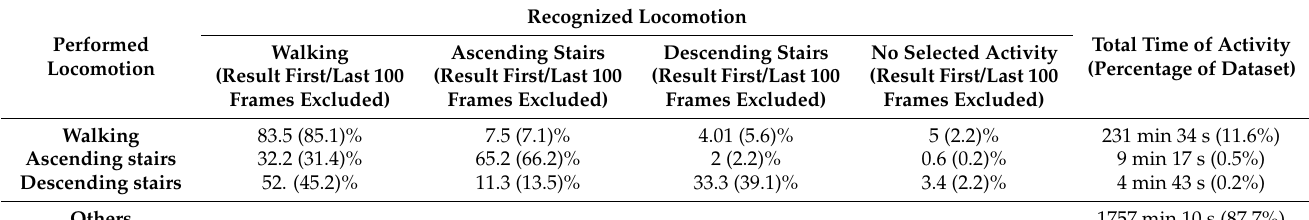
Table 5. Confusion matrix for testing dataset and dataset with exclusion of the first and last 100 frames of each walking and stair climbing